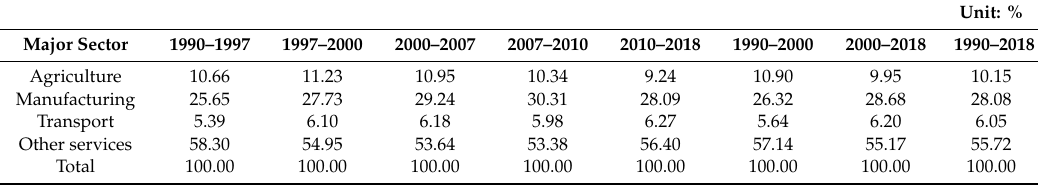
Table 2. Percentage share of production of major economic sectors, 1990–2018.